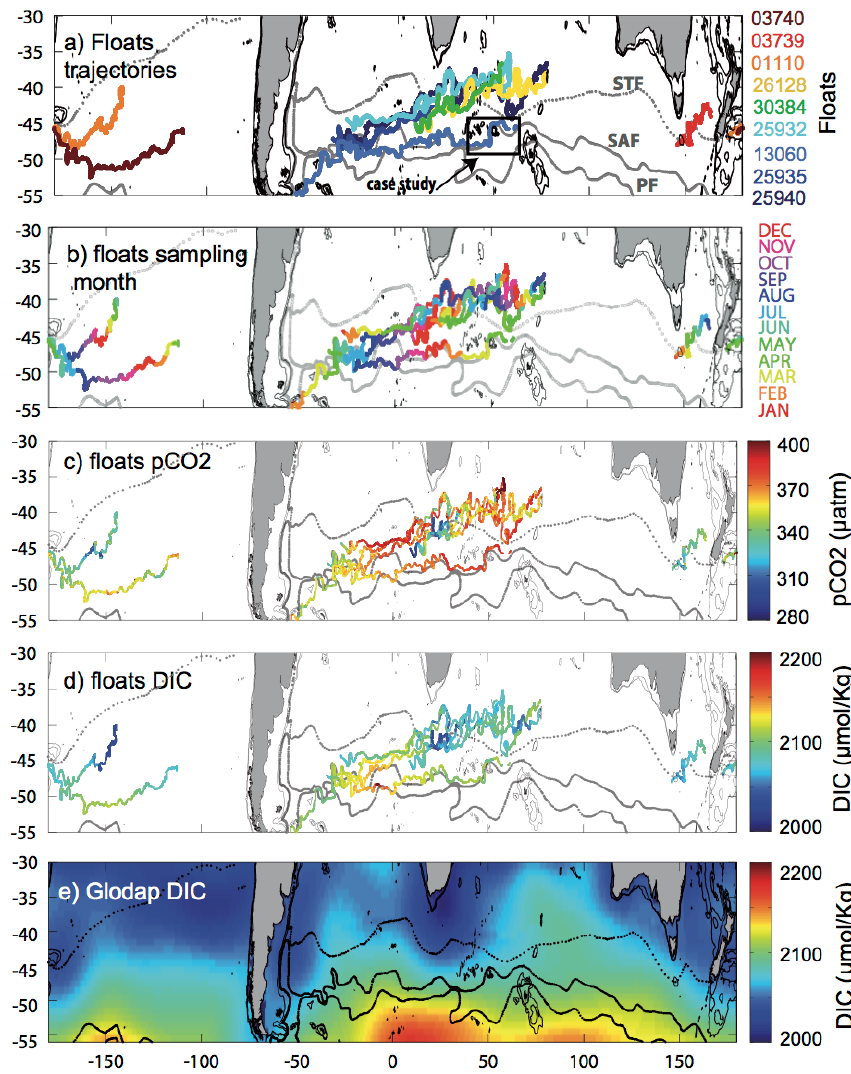
Fig. 1. (a) Drifters trajectories; (b) drifters sampling month; (c) drifters p CO 2 (in µatm); (d) drifters DIC (in µmolkg − 1 ) and (e) DIC in Glodap database (in µmolkg − 1 ). A correction of 0.7µmolkg − 1 yr − 1 has been applied to reference all DIC observations to the year